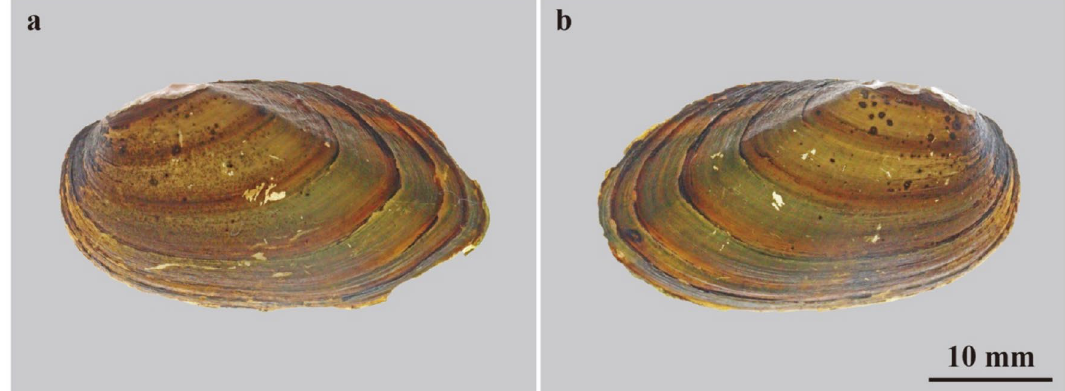
Figure 3. Color patterns of extant freshwater bivalves Nodularia douglasiae . ( a , b ) FPDM-I-0002915 from Lake Biwa, Shiga, Central Japan. ( a ) Left valve under transmitted light; ( b ) right valve under transmitted light.